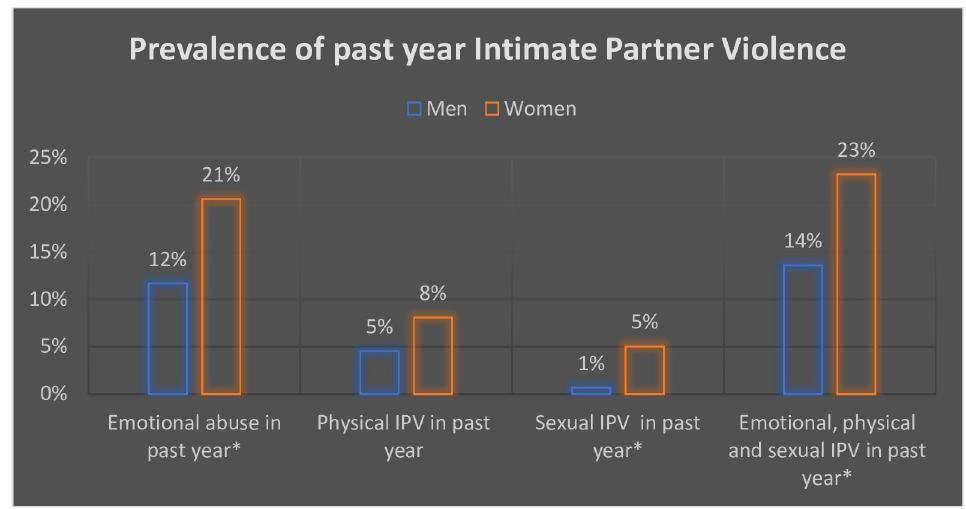
Fig 2. Prevalence of men’s perpetration of and women’s experiences of different forms of Intimate Partner Violence in the past year.